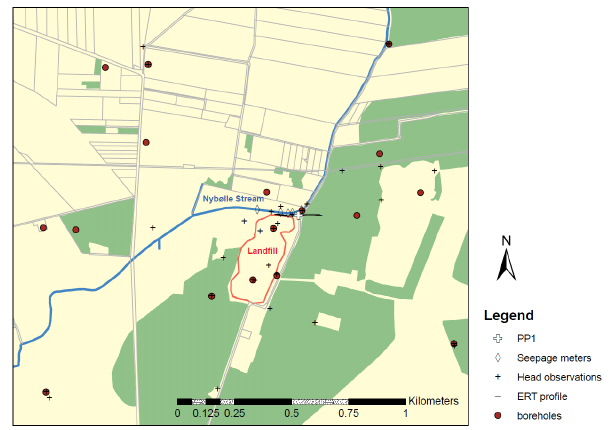
Fig. 6 An aerial overview of Risby landfill, the ERT profile, parameter PP 1 and available boreholes and hydrogeological observation 2 data at Risby landfill. 3 Fig. 6. An aerial overview of Risby landfill, the ERT profile, param- eter PP 1 and available borehole and hydrogeological observation data at Risby landfill.